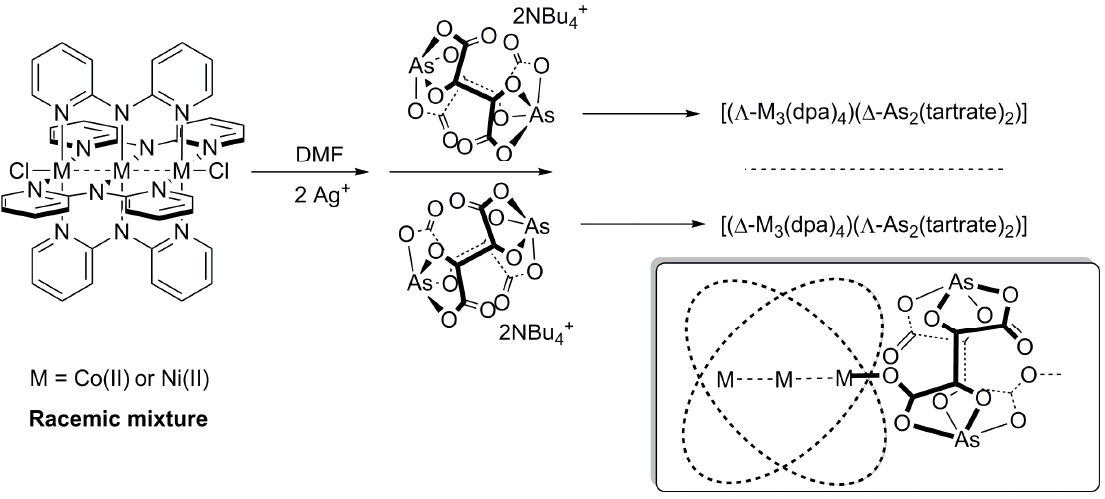
Figure 2. Synthetic approach employed to prepare chiral one dimensional Coordination Polymers (CPs) of the general formula [(M 3 (dpa) 4 )(As 2 (tartrate) 2 )] (M = Co(II) and Ni(II)). Inset: Representation of the coordination mode of the [As 2 (tartrate) 2 ] 2 − ligands.